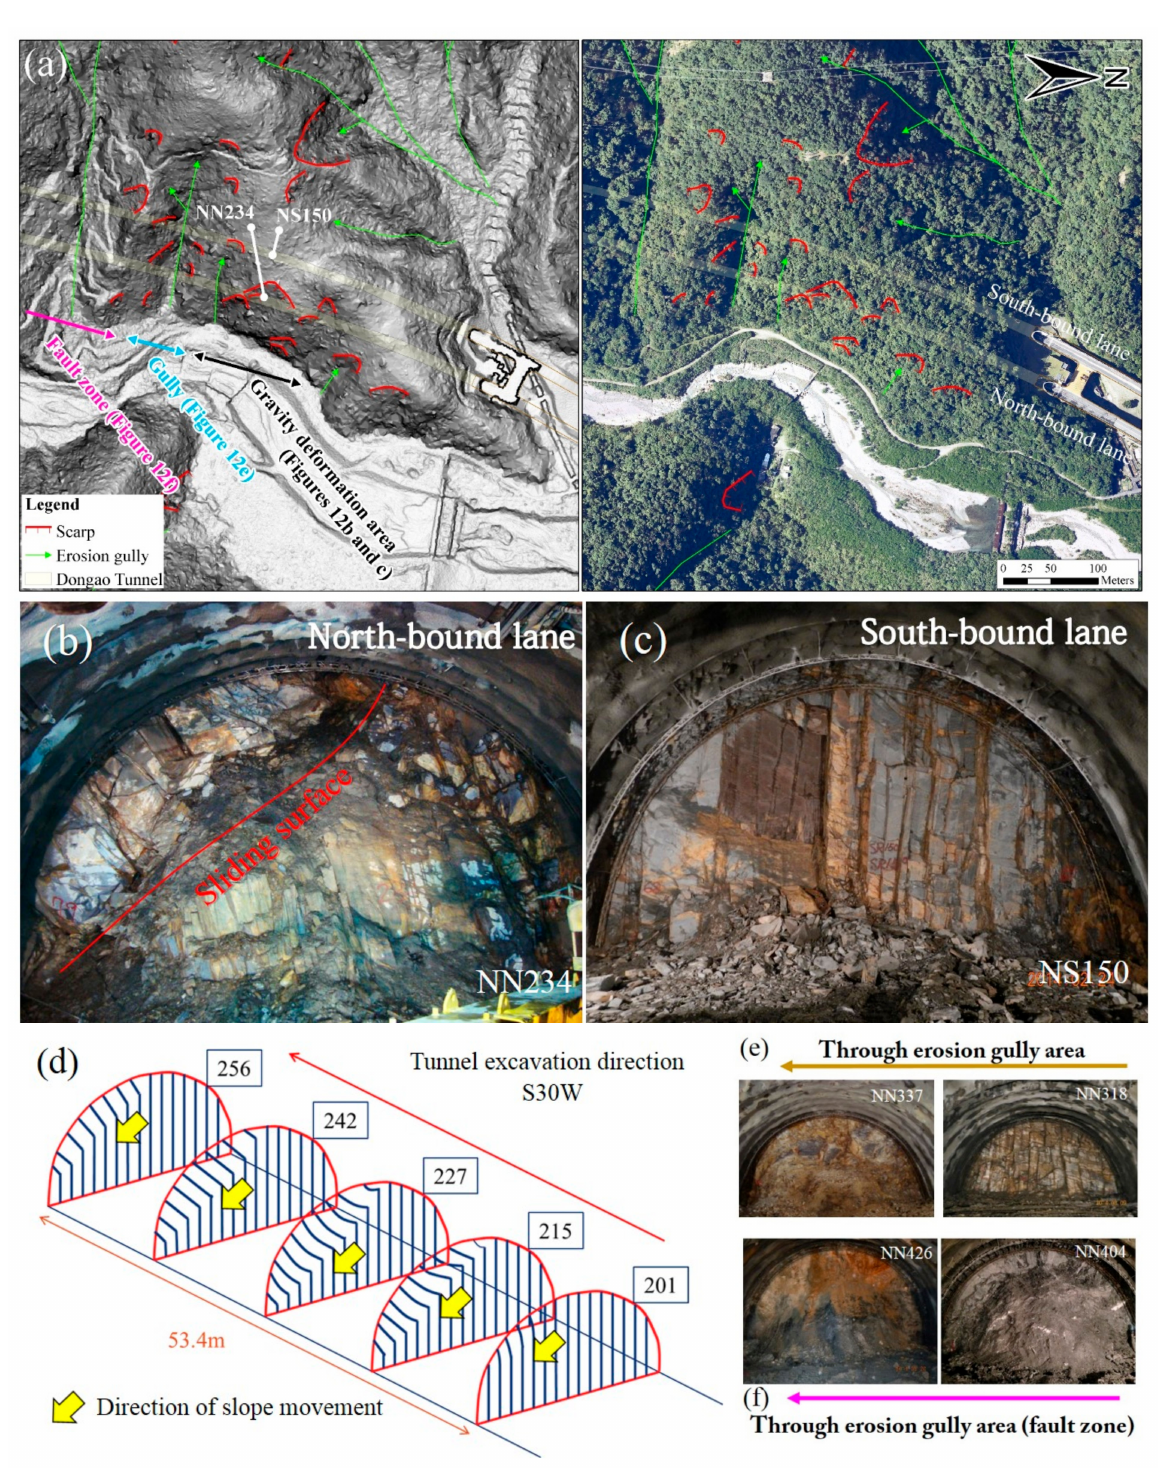
Figure 12. ( a ) Features of a rock mass under the gully and under the slope that was interpreted to exhibit deep-seated gravitational deformation. ( b ) Image captured from the excavation face of the north-bound lane in the tunnel under a scarp. ( c ) Image of excavation face at the location that corresponds to ( b ). ( d ) Sketch of rock mass deformation when the tunnel passes through the slope with deep-seated gravitational deformation. ( e ) Excavation face under the gully in the Suao Formation. ( f ) Excavation face under the gully on the north edge of the Xiaomaoshan